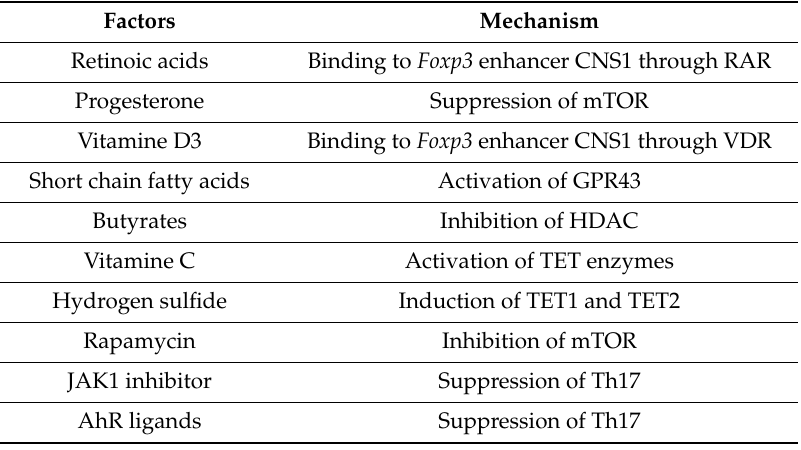
Table 1. Factors which induce or stabilize Foxp3